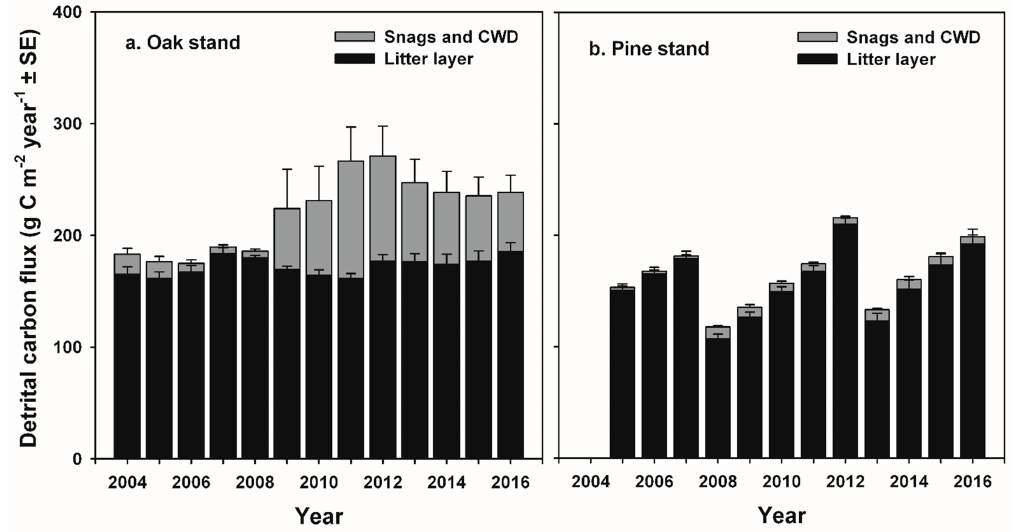
Figure A2. Estimated annual carbon release from fine litter in the L horizon on the forest floor, standing dead, and coarse woody debris at the ( a ) oak and ( b ) pine stands.